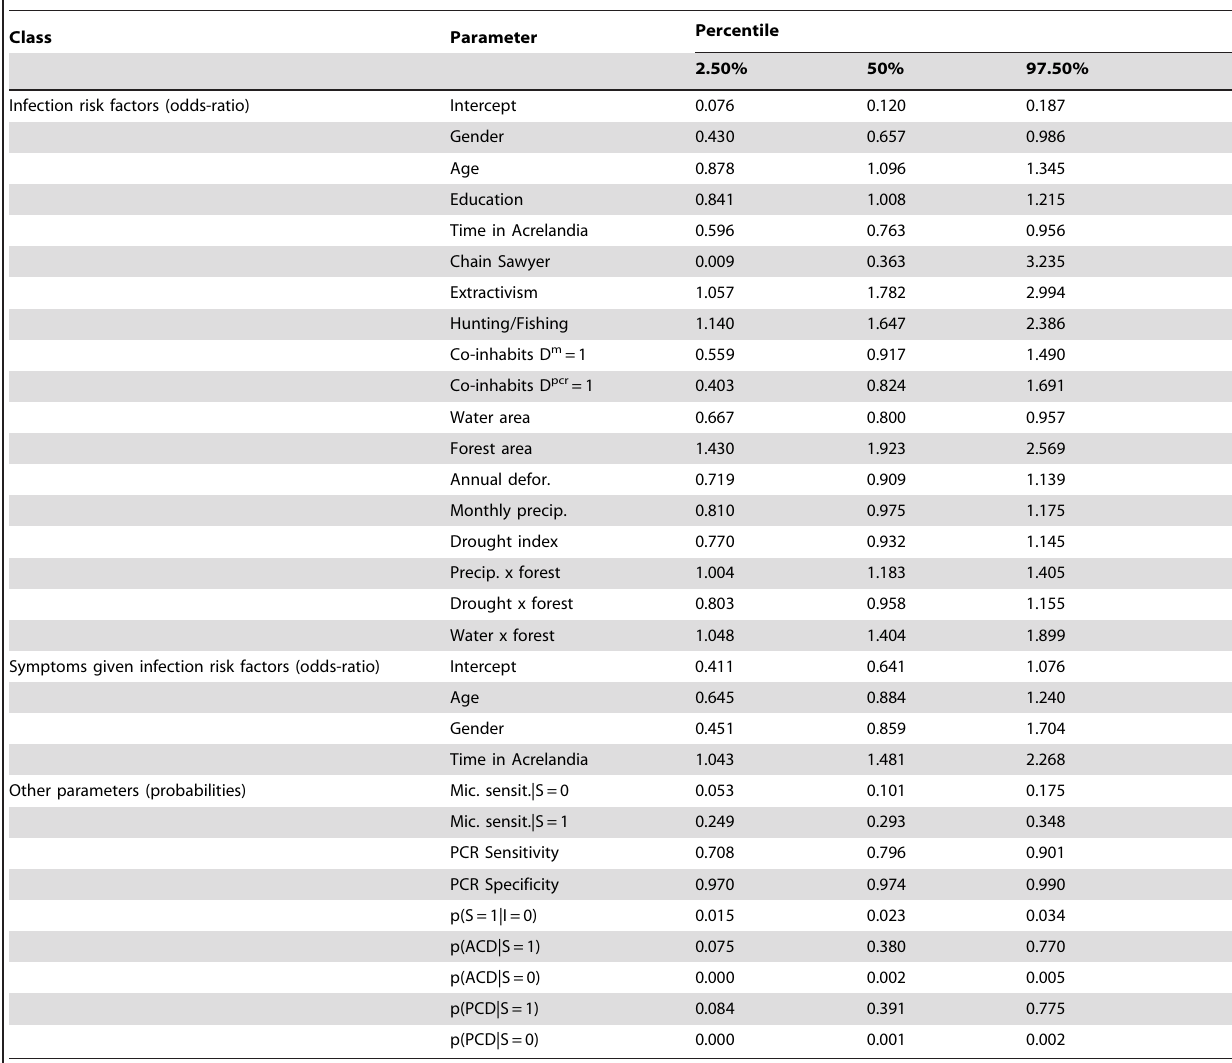
Table 3. Summary statistics for the estimated